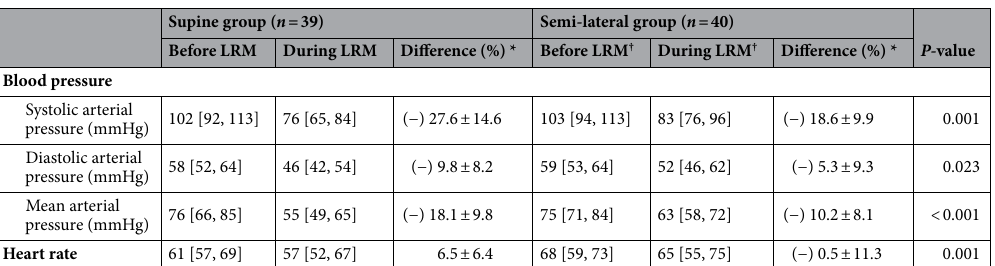
Table 2. Hemodynamic parameters difference during the sustained inflation lung recruitment maneuver. Data are presented after normal distribution was assessed by Kolmogorov–Smirnov test. The systolic arterial pressure, diastolic arterial pressure, mean arterial pressure, heart rate before and during LRM are presented as median [25th percentile, 75th percentile], while the difference in values are presented as mean ± SD. *Difference is defined as the minimum values during the sustained inflation lung recruitment maneuver minus the value before lung recruitment maneuver and is expressed as a percent of the value before recruitment